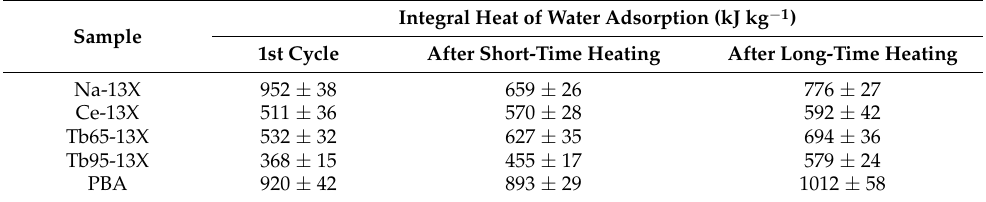
Table 2. Averaged values of the integral heat released upon the adsorption of water vapor in three representative saturation